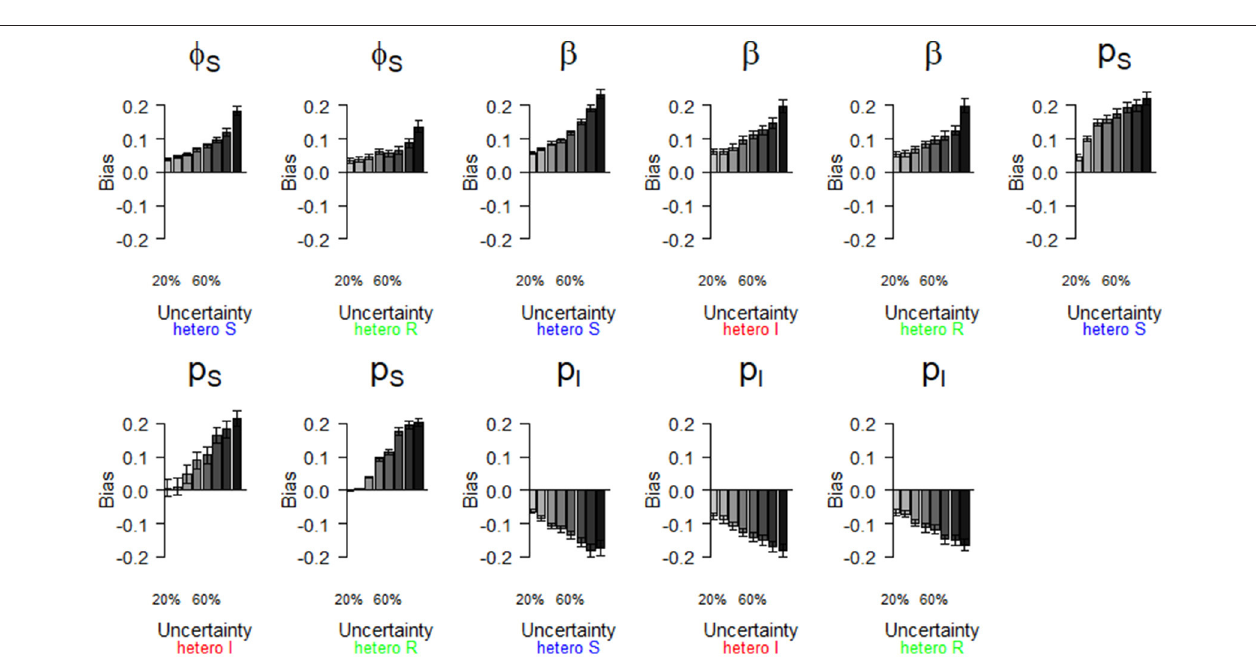
FIGURE 4 | Precision (mean squared error, MSE)) of parameter estimates as a function of homogeneously increasing infection state uncertainty. The increasing state uncertainty on the x-axis corresponds to a decreasing probability of assigning an infection state. We used the following notations for the parameters: φ S , φ I and φ R for the survival probability of individuals in S, I and R states, β for the infection probability, p S , p I , and p R for the detection probability and δ S , δ I , and δ R for the assignment probability of individuals in S, I and R states, respectively.